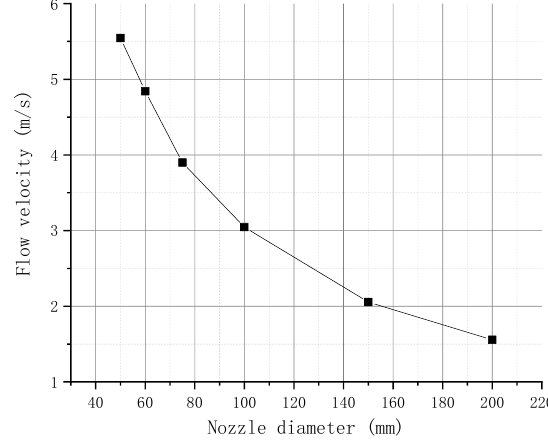
Figure 8. Flow velocity in different nozzle diameters.